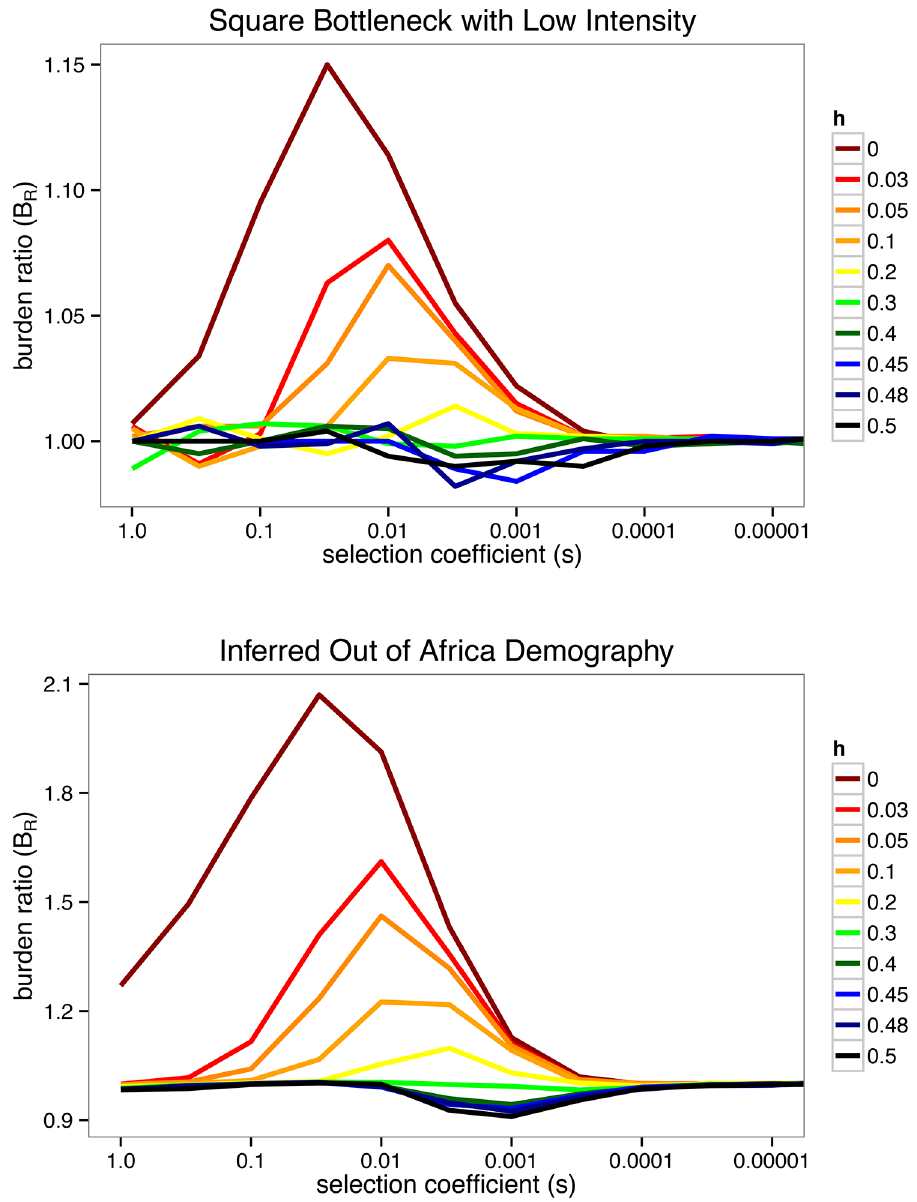
Fig 3. The B R statistic at the time of observation. ABOVE: At the time of observation t obs , the value of t s and dominance coefficient h . B R ( obs ) is plotted as a function of the average strength of selection Dominance coefficients appear as solid lines with fully recessive selection ( h = 0) at the top and purely ) at the bottom. For strong selection B R ! 1 due to the rapid transient response. For additive selection ( h ¼ 1 2 weak selection B R ! 1 due to the nearly neutral insensitivity to the bottleneck. For some intermediate dominance coef fi cient h c , a critical value occurs ( h c * 0.25 in the example shown, but explored more generally in S1 Text) where additive and recessive effects cancel, yielding B R ( h c ) * 1. A low intensity bottleneck ( I B = 0.05) is shown, with parameters 2 N 0 = 20000, 2 N B = 2000, T B = 100, and t obs = 1000. BELOW: The same range of parameters is plotted for a realistic demographic model of the Out of Africa event comparing Africans and Europeans [48], where B R = h x i African / h x i European . The European bottleneck has estimated intensity I B * O (0.5), an order of magnitude stronger than the simple bottleneck above, allowing for potentially observable deviations from B R * 1 if a large fraction of analyzed variants act recessively with h * < h c